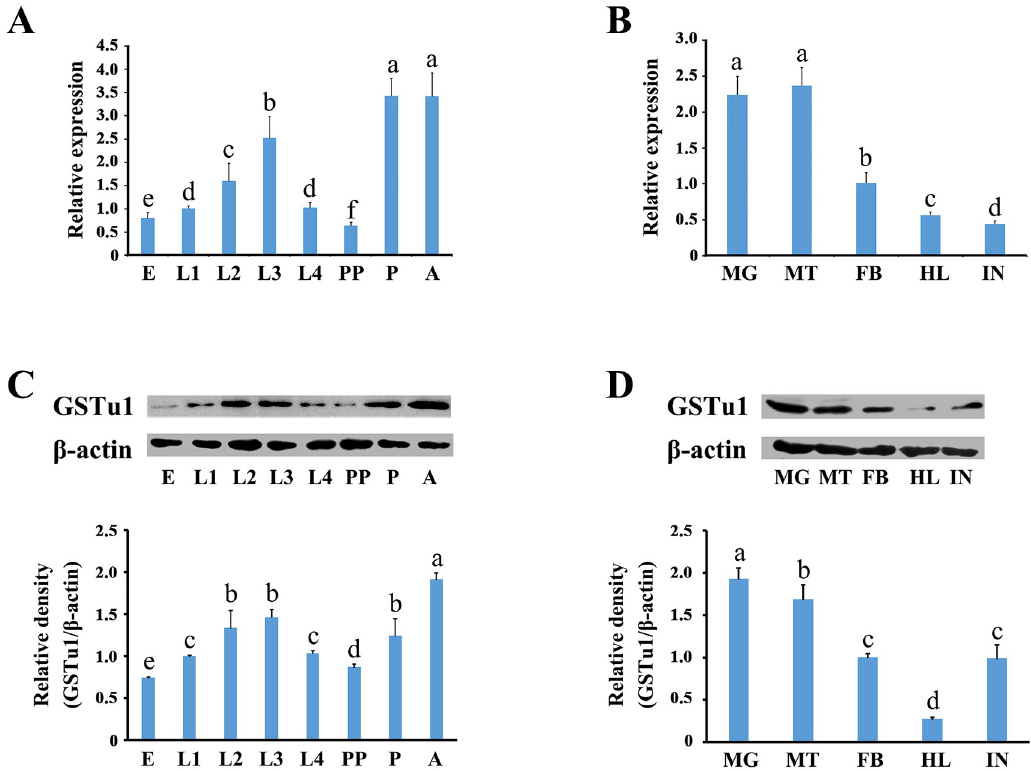
Fig 2. Expression of GSTu1 at different developmental stages and in different tissues. E: egg; L1-L4: the first- to fourth-instar larvae; PP: pre-pupae; P: pupae; A: adult. MG: midgut; MT: malpighian tubule; FB: fat body; HL: haemolymph; IN: integument. Different lowercase letters represent significant differences (one-way ANOVA followed by Tukey’s multiple comparison tests, P <